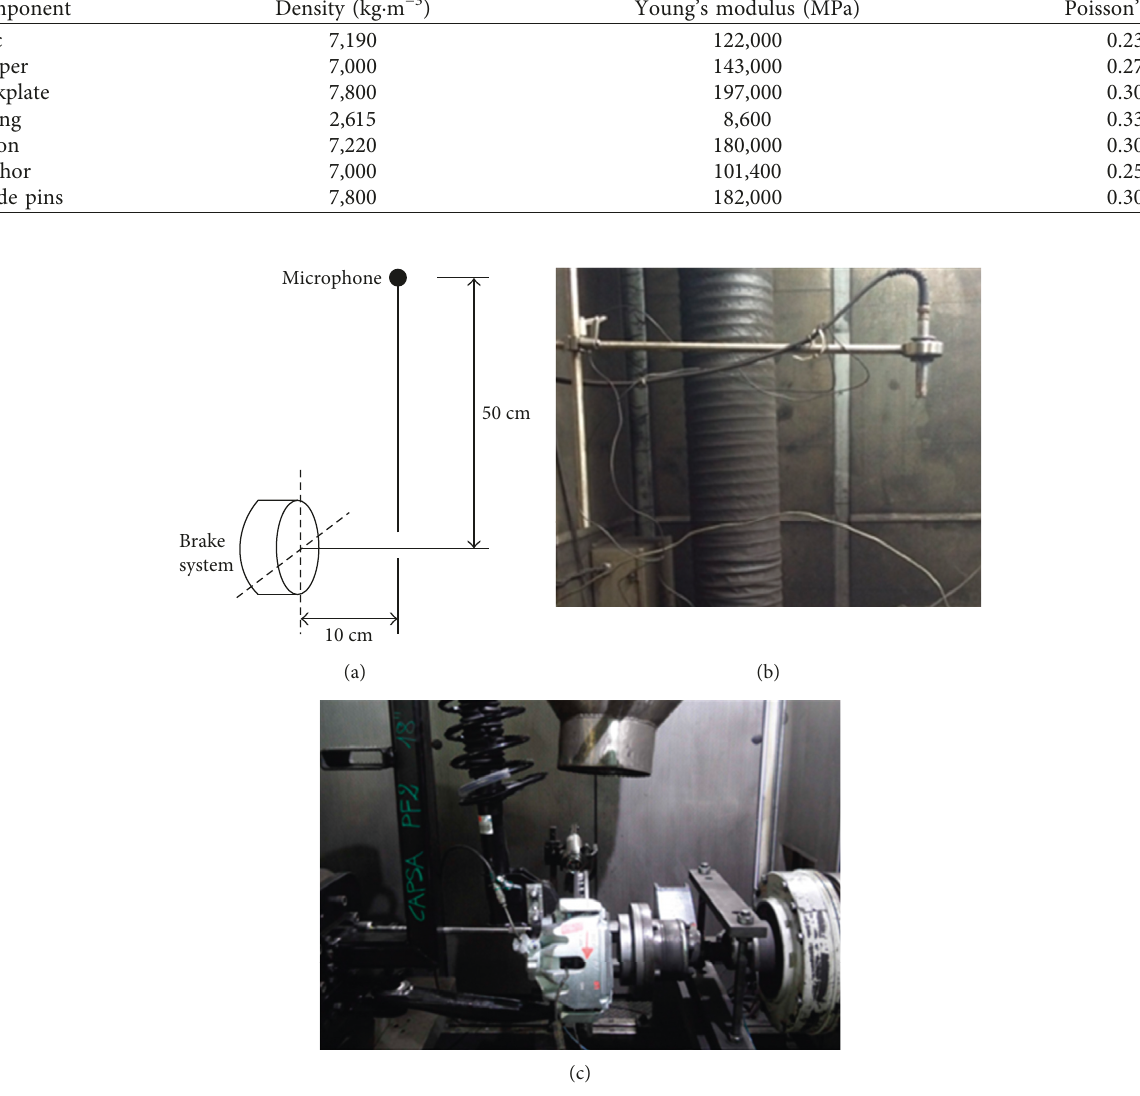
Figure 3: (a, b) Location of microphone and picture of real product and (c) disc brake assembled on test